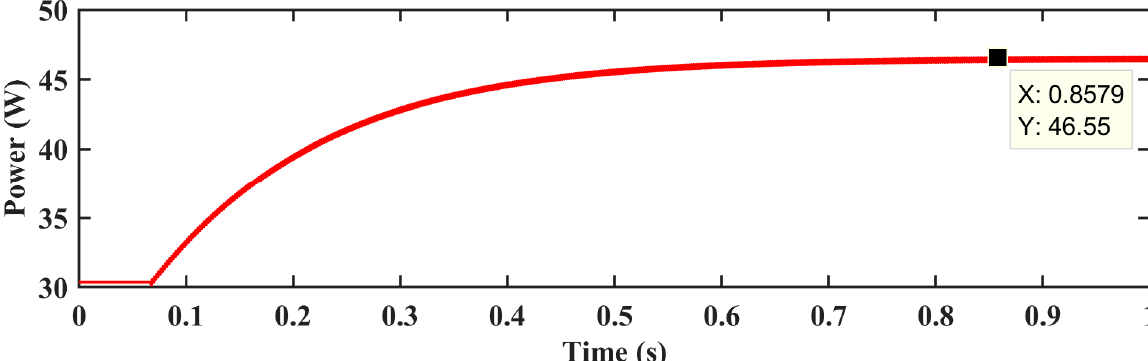
Figure 20. PSO-GRNN tracked power.